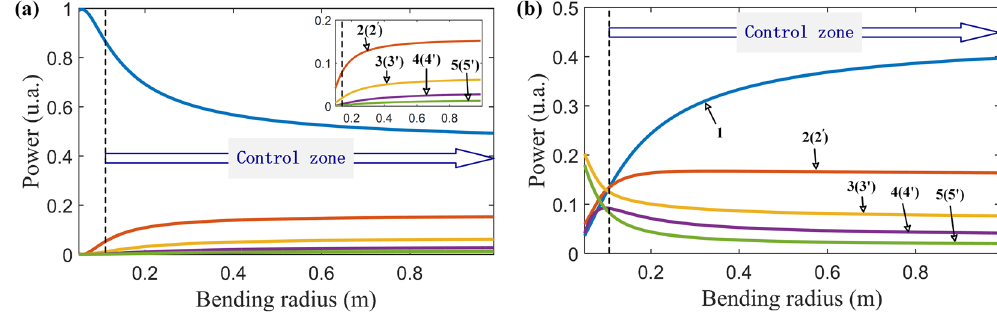
Figure 6. The output powers from arrayed cores of the Airy fiber as a function of bending radius. ( a ) Bending along the positive X1-aixs direction. ( b ) Bending along the negative X1-aixs direction. Note that we do not consider the bending loss for a short Airy fiber with several millimeter lengths. Inset in ( a ) shows zoomed-in partial